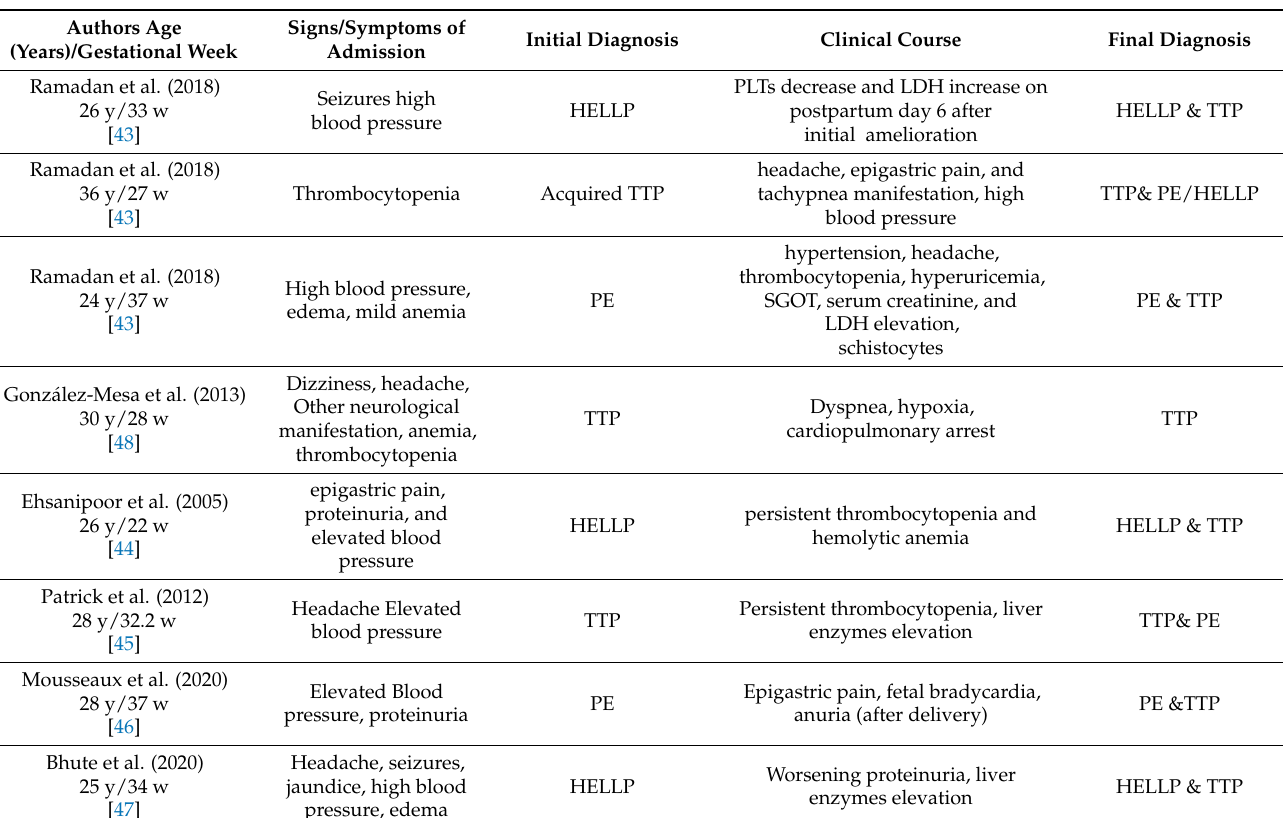
Table 4. Collected bibliographic data concerning published case reports with complicated differential diagnosis